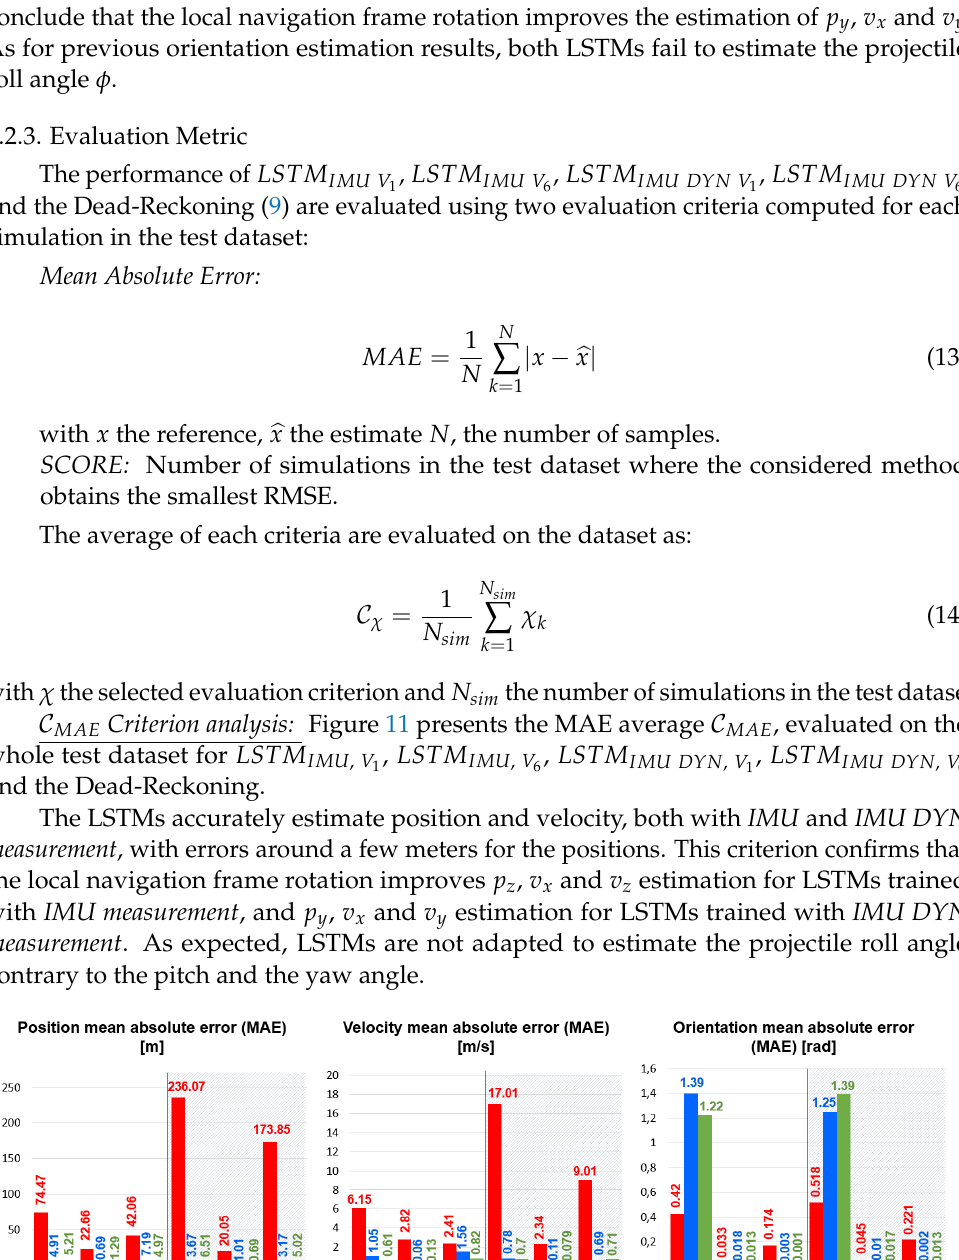
, LSTM IMU DYN , V 1